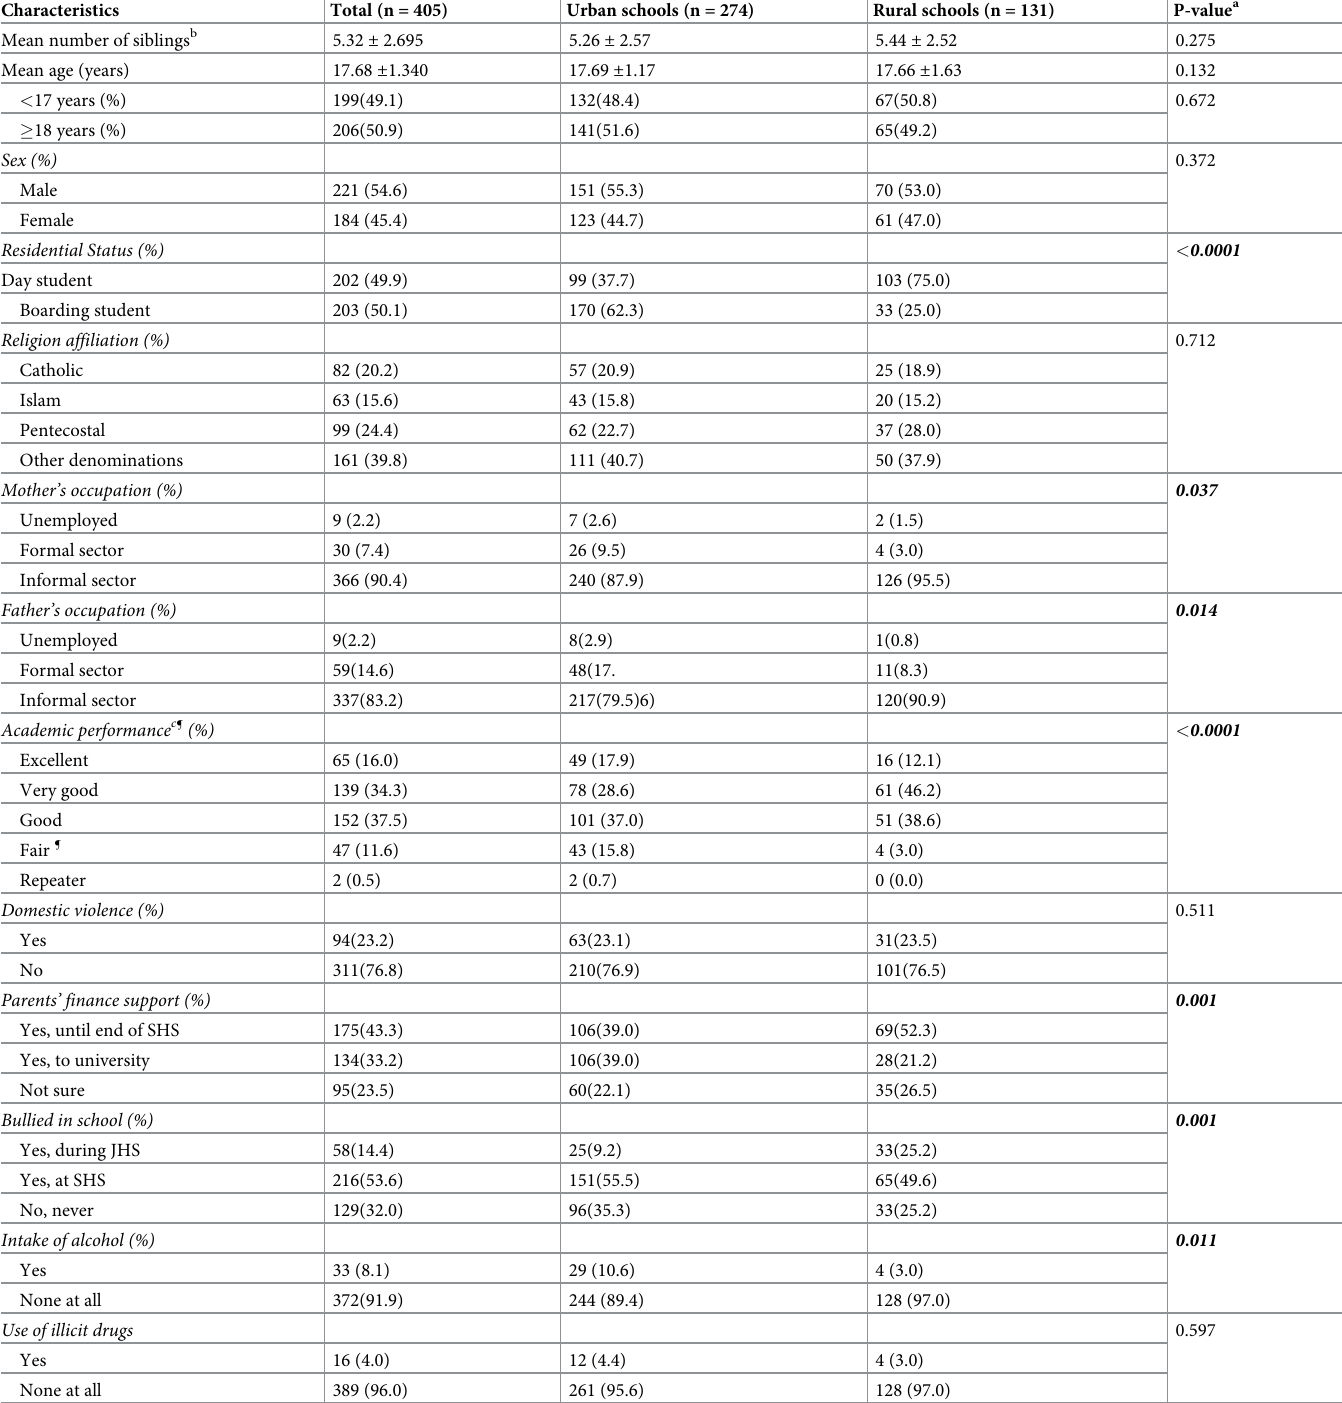
Table 1. Socio-demographic characteristics of study participants stratified according to the geographical location of the